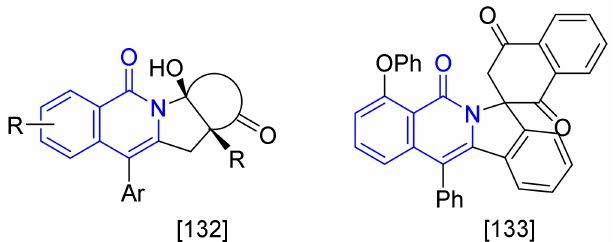
Figure 3. Ruthenium(II)-catalyzed syntheses of polycyclic fused